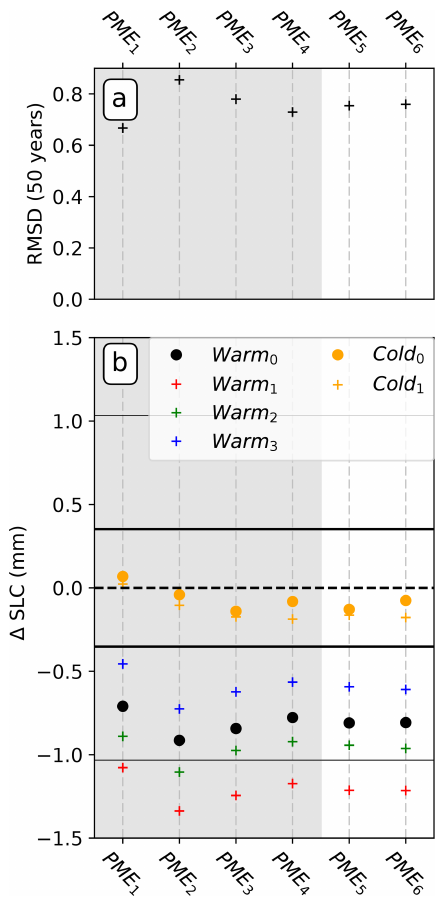
Figure C1. Similar to Fig. 9 but to evaluate the use of the local gra- dient in PME 3 (which gives PME 5 ) and PME 4 (which gives PME 6 ) to calculate the effective angle instead of using the slope between the ice draft and the grounding line from which the plume starts. The calibration of PME 5 and PME 6 is done with α = 0 . 34 and α = 0 . 65, respectively (Sect. 3.2). The grey shading is only to ease the com- parisons between the